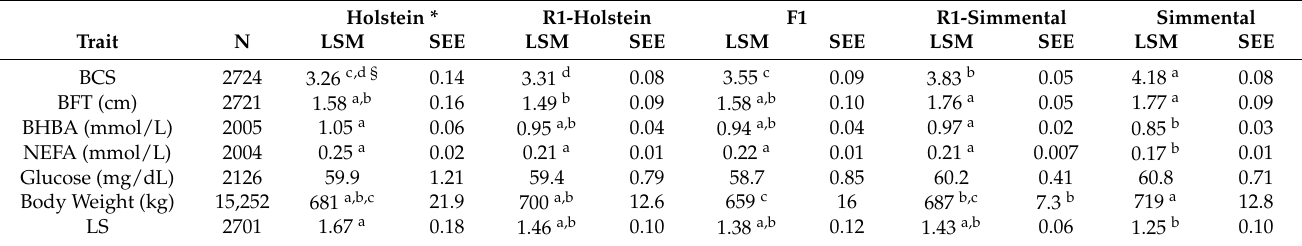
Table 1. Least squares means (LSM), standard errors of estimation (SEE) and observation numbers (N) for body condition score (BCS), back fat thickness (BFT), beta-hydroxybutyrate (BHBA), non-esterified fatty acids (NEFA), glucose, body weight, and locomotion score (LS) of Holstein, R1-Holstein, first generation (F1)-Crossbred, R1-Simmental, and Simmental cows. Holstein *